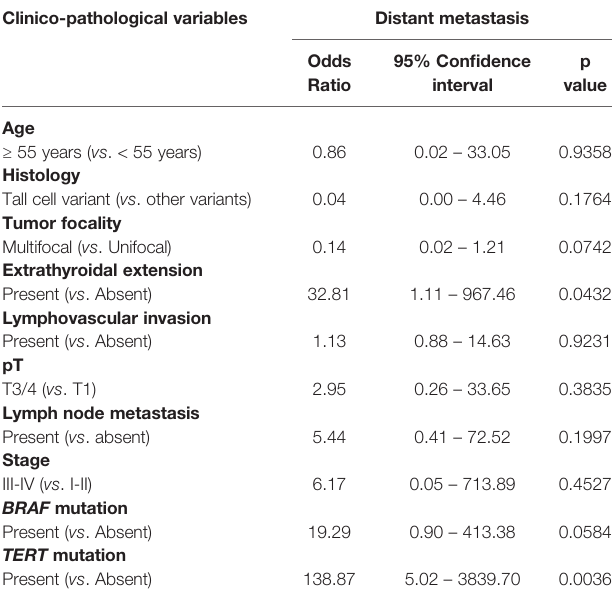
TABLE 5 | Multivariate analysis using logistic regression model for prediction of distant metastasis. Clinico-pathological